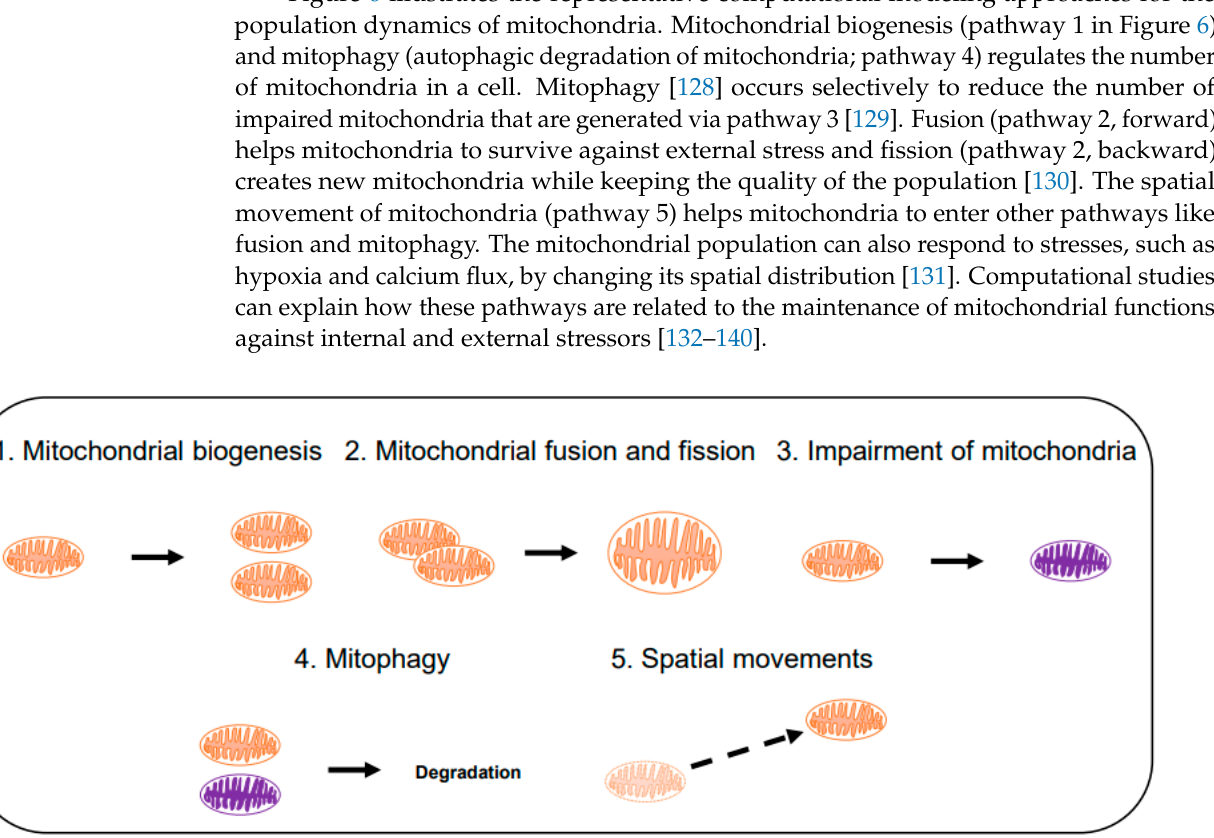
Figure 6. Computational modeling of mitochondria at a population scale. Major pathways for mitochondrial population dynamics are illustrated. Orange and purple colored mitochondria represent normal and impaired mitochondria, respec- tively.